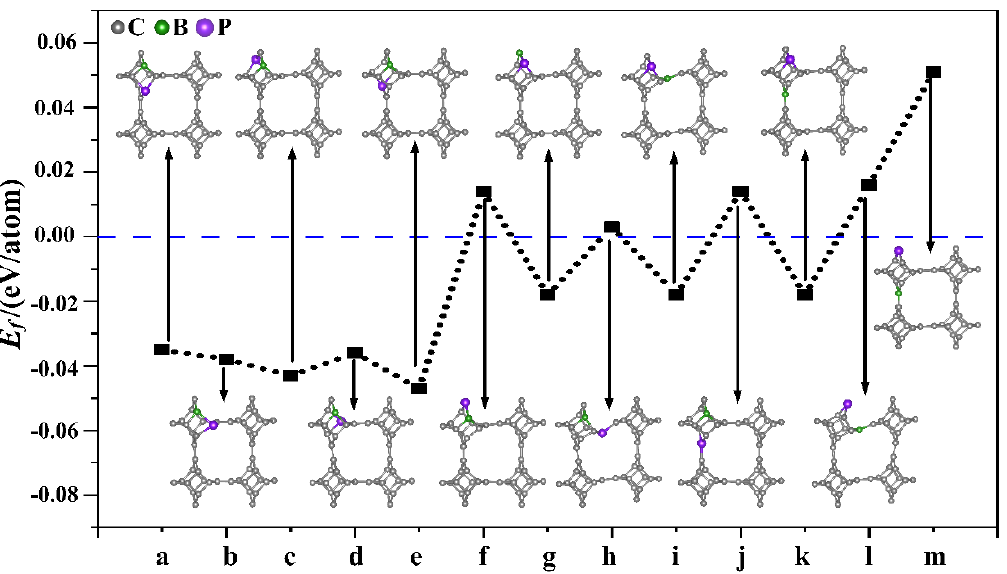
Figure 2. Different doping systems (TTG/BP) and their corresponding formation energies. ( a – m ) are 13 different doping configurations.